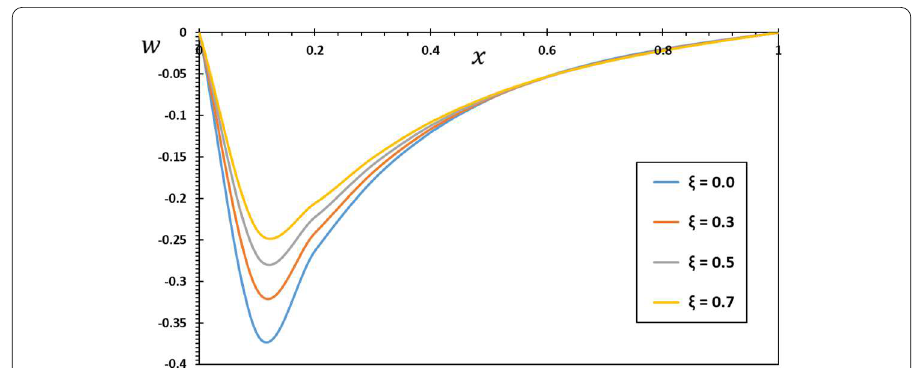
Figure 6 The effect of nonlocality ( ξ ) on the variation of the deflection w